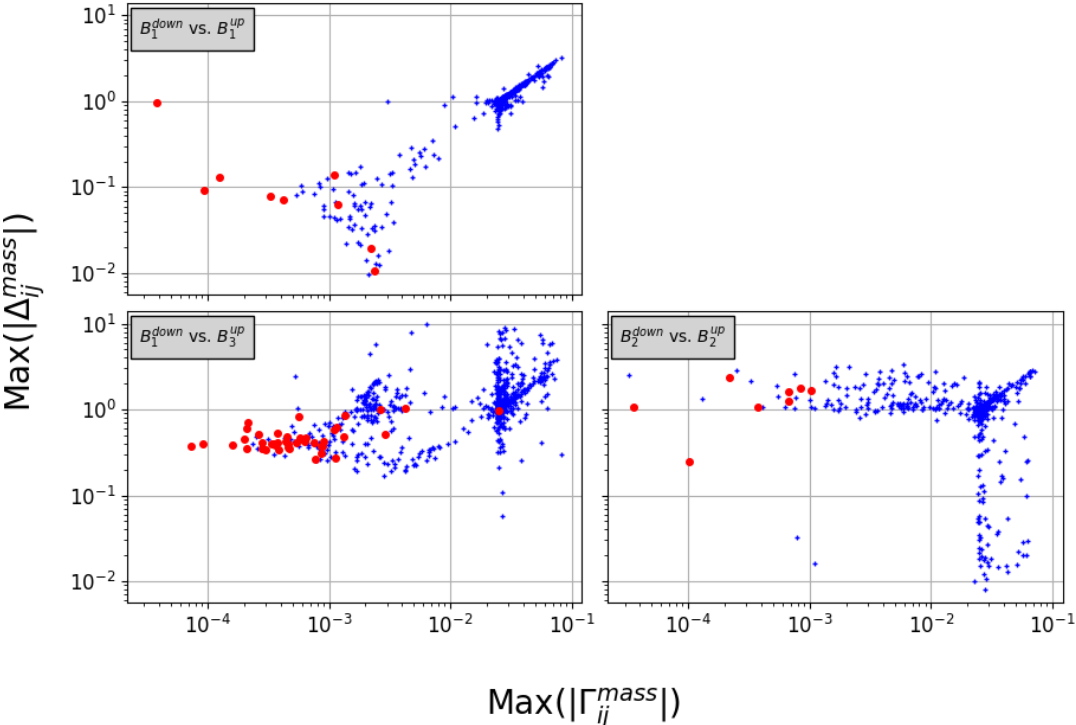
Figure 8 . Maximal values of o(cid:11)-diagonal elements in the mass basis for the scenarios ( B 1 ; B 1 ) (upper left), ( B 1 ; B 3 ) (lower left), and ( B 2 ; B 2 ) (lower